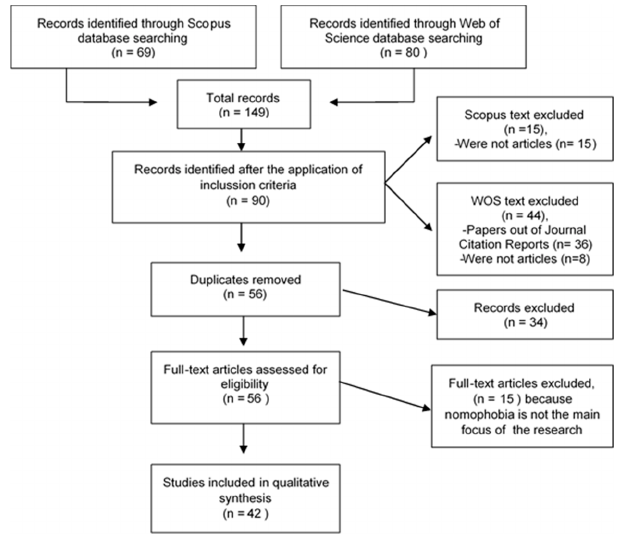
Figure 1. Flow diagram.